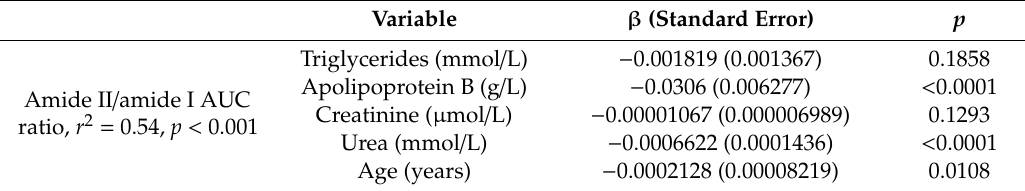
Table 2. Multiple regression model with the amide II/amide I area under the curves (AUC) ratio as dependent variable. Variable β (Standard Error)